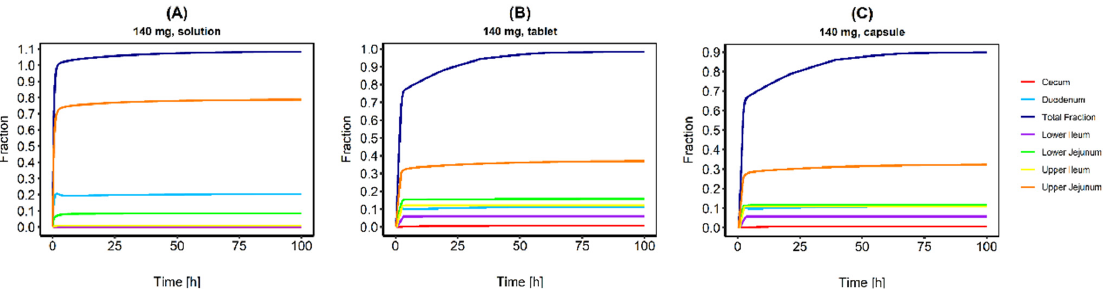
Figure 2. Simulation of the absorbed CAB fractions in different intestine sections after administration of a CAB 140 mg solution ( A ), tablet ( B ) and capsule formulation ( C ).